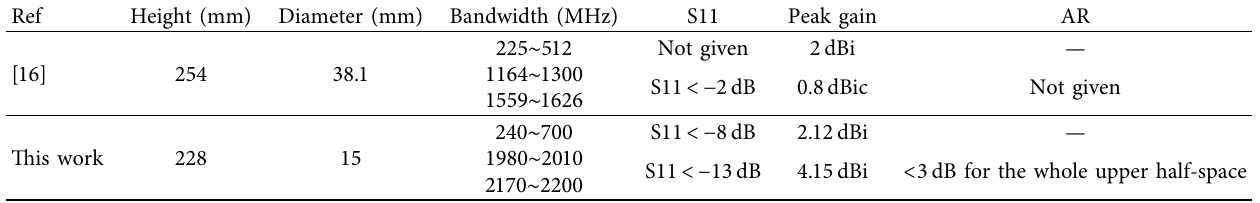
Table 3: Comparison of the proposed antenna with the previous